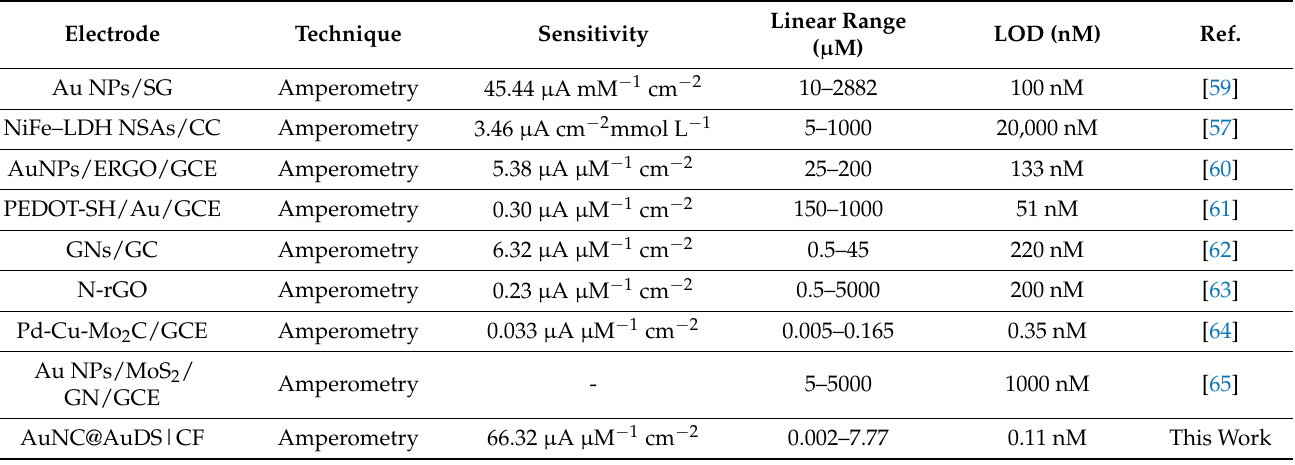
Figure 5. ( a ) Chronoamperometric i -t curve of the AuNC@AuDS|CF ( b ) microelectrodes upon adding various NO 2 − concentrations (from 2 nM to 7.8 µM); ( b ) the calibration plot of Figure 5a. Table 1. List of reported electrochemical sensors with present sensor based on AuNC@AuDS|CF microelectrodes towards the NO sensing.